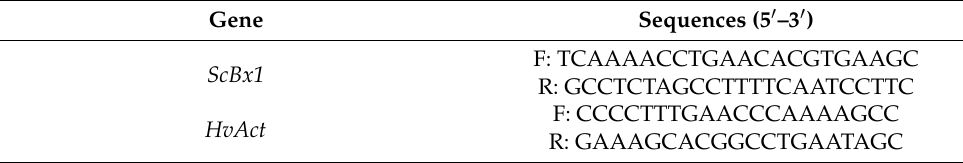
Table 1. Primers used in the qRT-PCR reactions. Gene Sequences (5 (cid:48) –3 (cid:48)